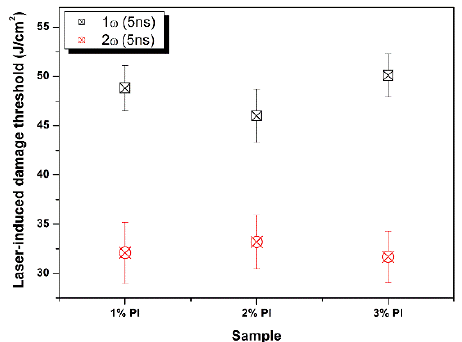
Figure 4. 1 ω and 2 ω laser-induced damage threshold (LIDT) of HRI coatings with different PI concentrations.